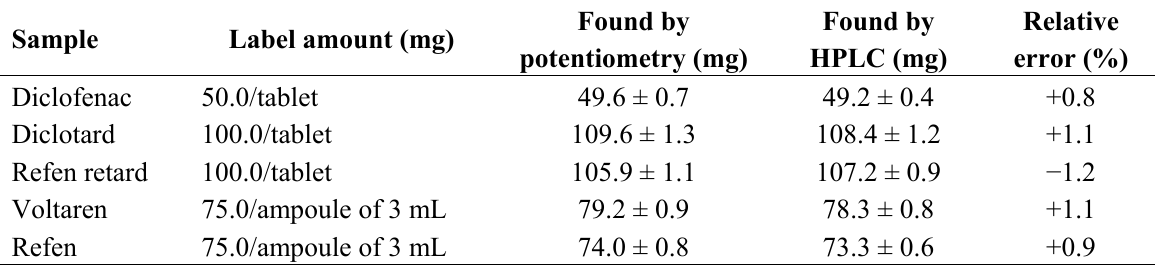
Table 5. Determination of diclofenac in pharmaceutical